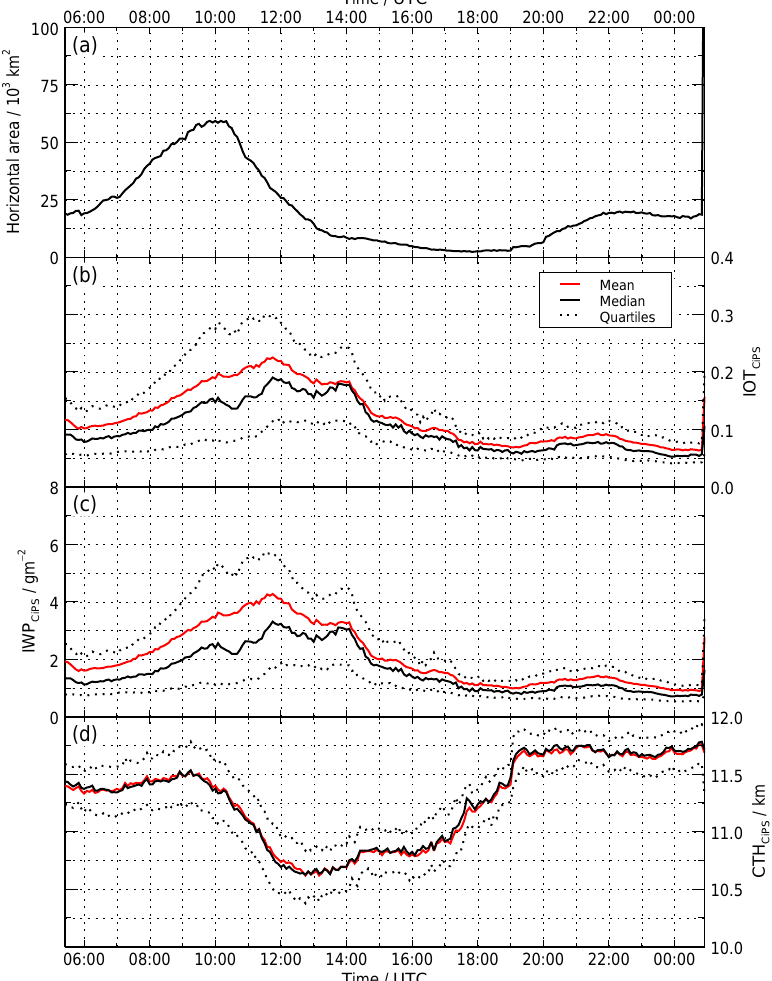
Figure 14. Temporal evolution of the cloud properties for the cirrus described in Fig. 13 with a temporal resolution of 5min: (a) the horizontal cirrus cloud area, (b) IOT, (c) IWP and (d) CTH. For the IOT, IWP and CTH the mean, median, upper and lower quartile values are